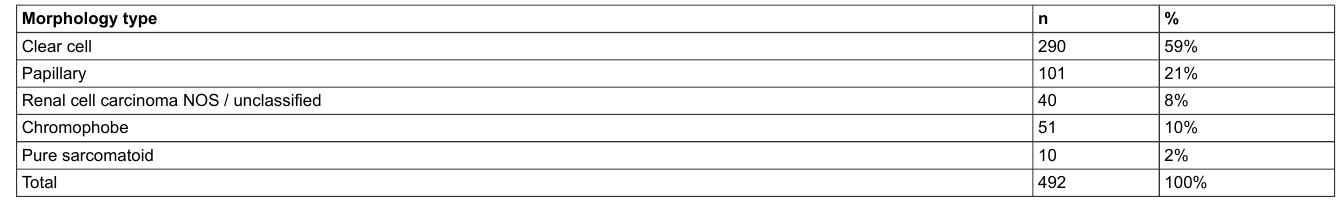
Table 1: Distribution of morphology types.